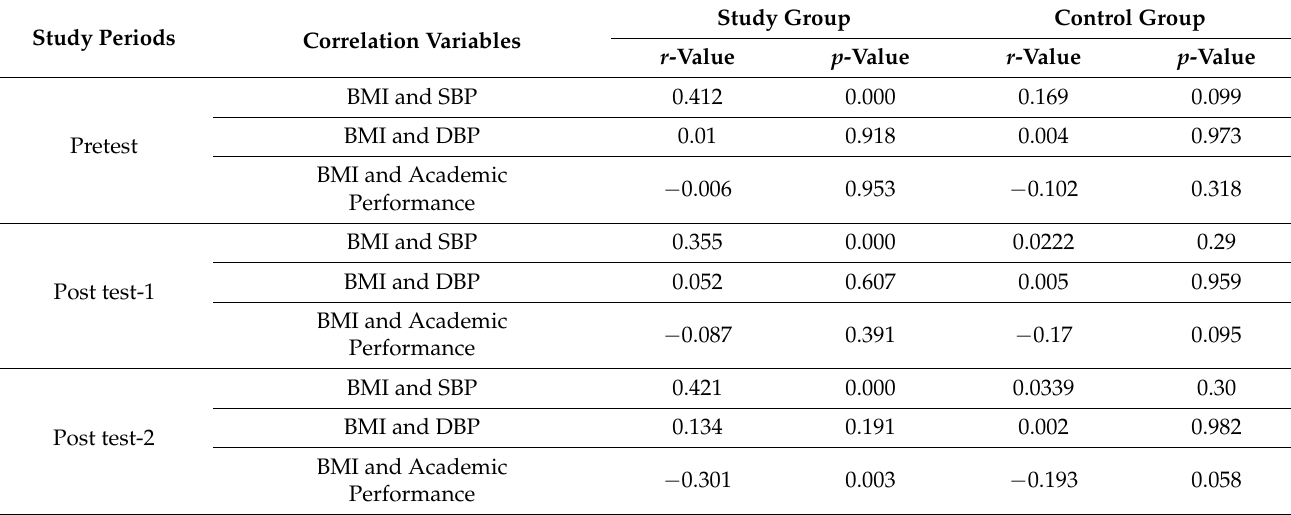
Figure 4. Relationship between BMI and SBP of Study and Control group. Table 8. Relationship among BMI, SBP, and DBP of study and control